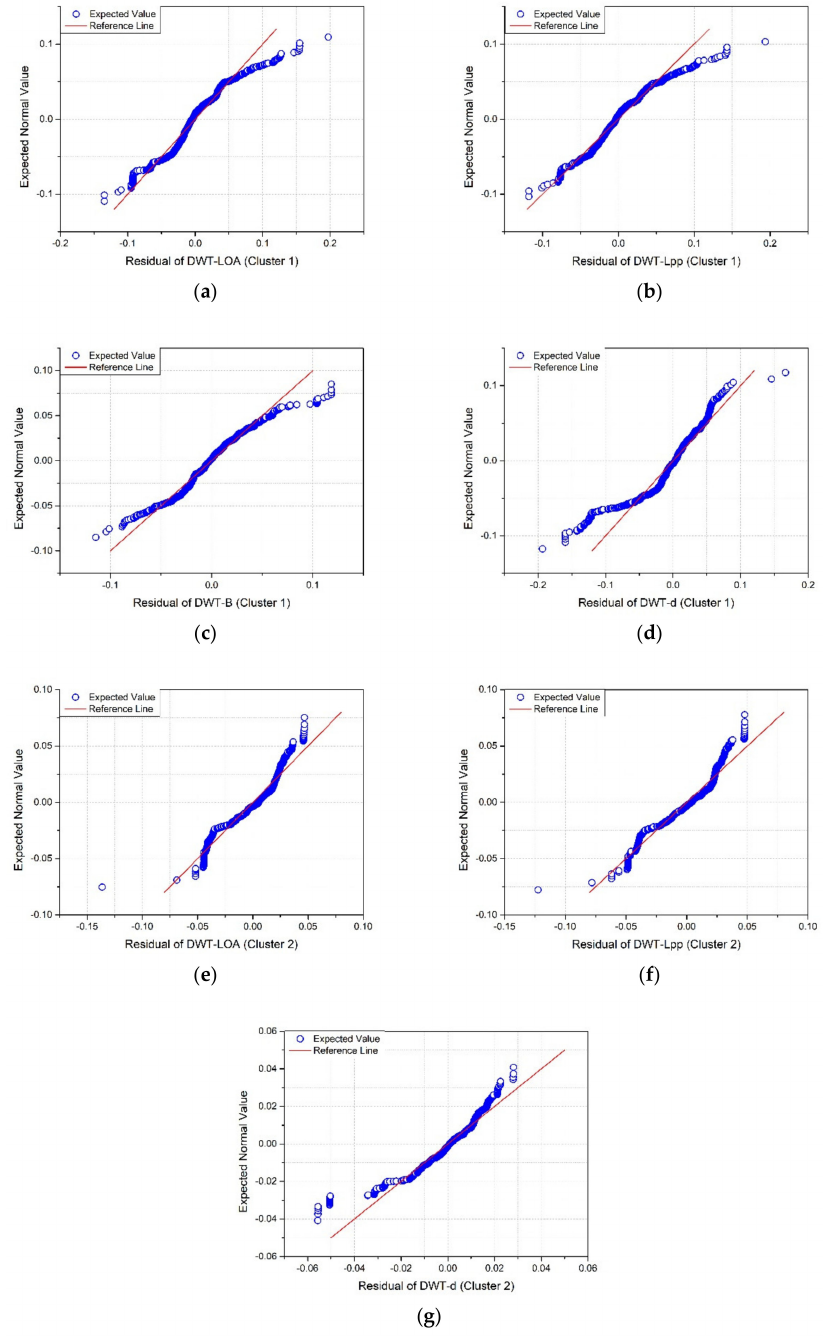
Figure 18. Results of normal Q-Q plot. ( a ) Deadweight tonnage (DWT)-Length overall (LOA) graph of Cluster 1; ( b ) DWT-Length between perpendiculars (Lpp) graph of Cluster 1; ( c ) DWT-breadth (B) graph of Cluster 1; ( d ) DWT-draft graph of Cluster 1; ( e ) DWT-LOA graph of Cluster 2; ( f ) DWT-Lpp graph of Cluster 2; ( g ) DWT-d graph of Cluster